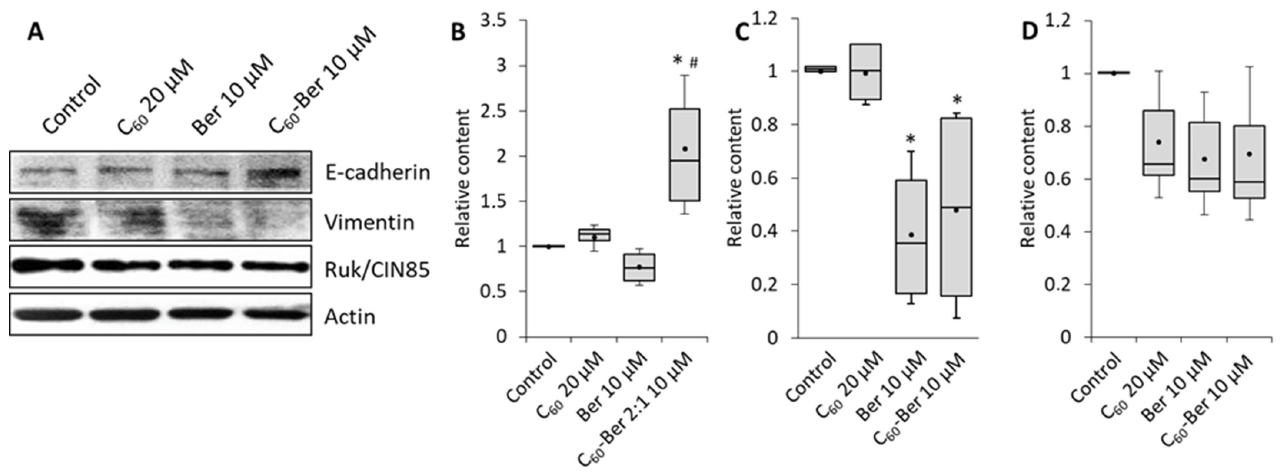
Figure 3. C 60 -Ber nanocomplex modulates the content of EMT molecular markers in LLC cells: ( A )—representative results of Western-blot analysis; ( B – D )—quantitative analysis of E-cadherin, vimentin, and Ruk/CIN85 content, respectively. Box-plot legend: box represents second and third quartiles; whiskers—minimal and maximal values; dot—mean value. * p < 0.05 compared to control; # p < 0.05 compared to free Ber.